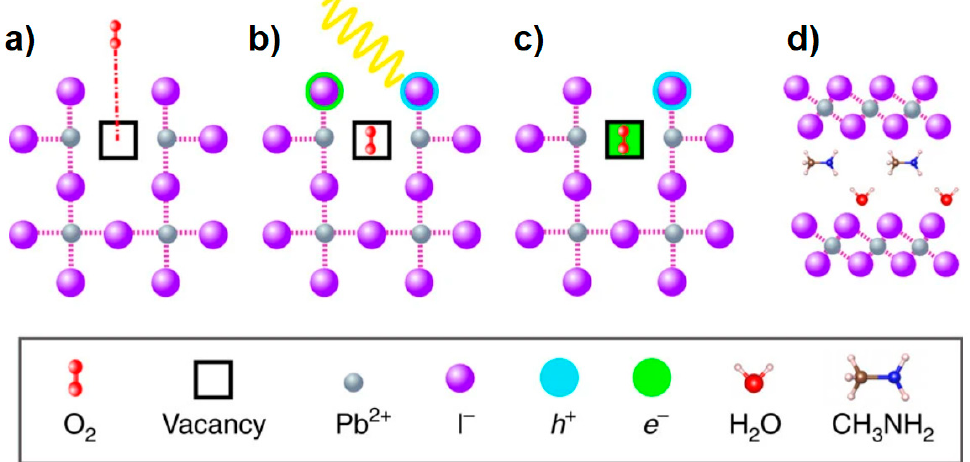
Figure 5. Schematic mechanism of the degradation of the perovskite structure (e.g., CH 3 NH 3 PbI 3 ) by the action of oxygen under light conditions: a) oxygen diffusion, b) Light absorption, c) Formation of superoxide radicals, and d) degradation of the perovskite. Adapted from [109].